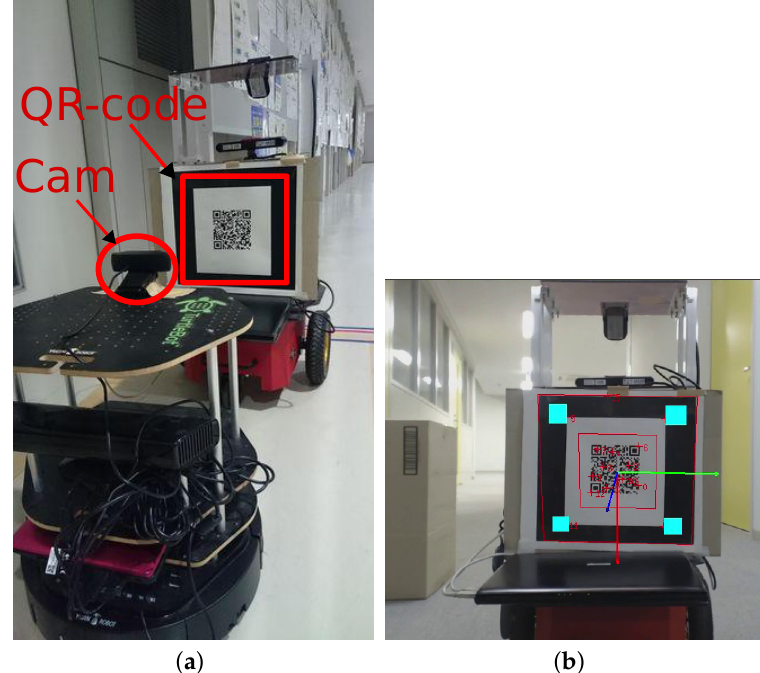
Figure 1. QR code and camera system for coupling. ( a ) Robot with fixed QR code and camera for visual servoing; ( b ) An example of pose estimation from QR-code in visual